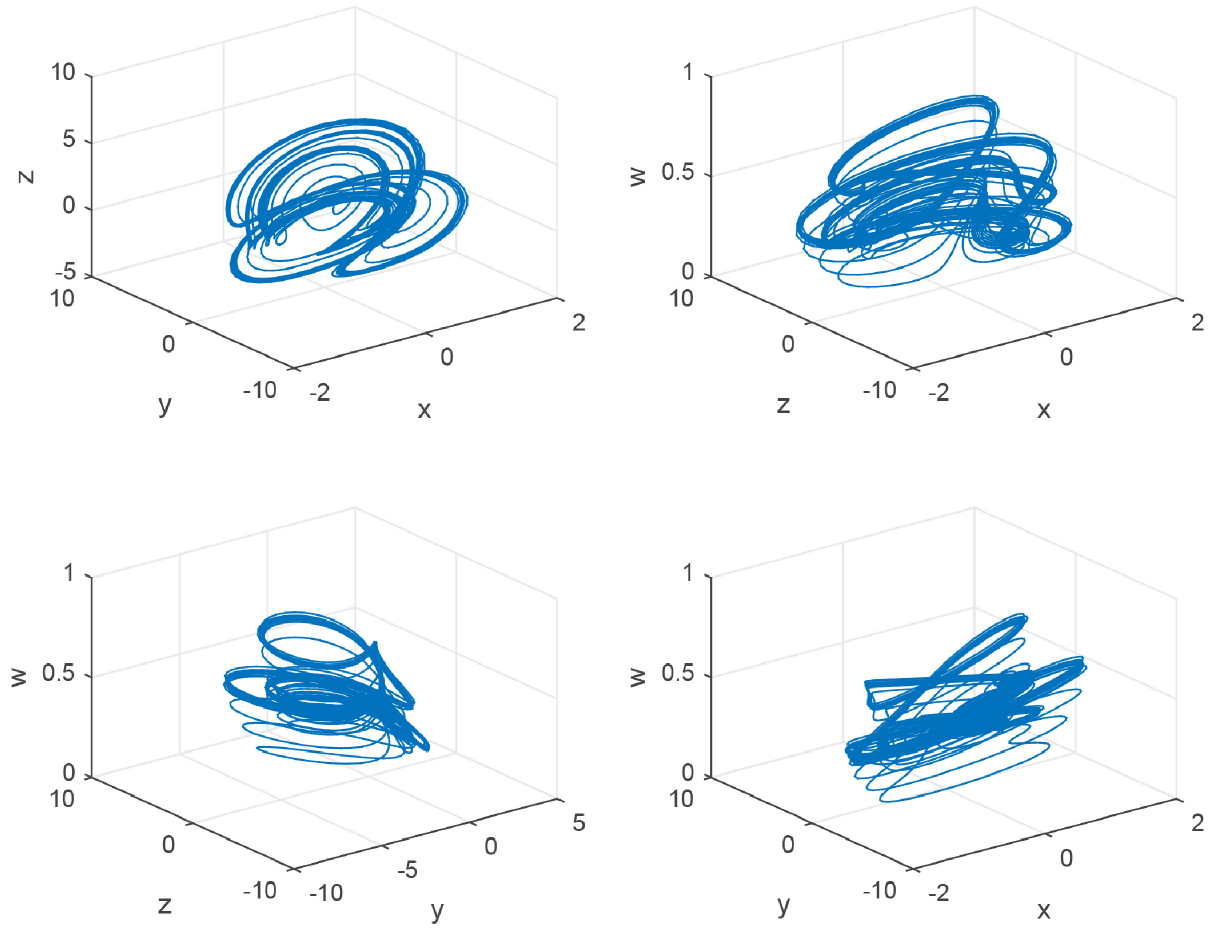
Fig 5. The 3D view of the GDDS chaotic attractor with c 2 = 0.071.